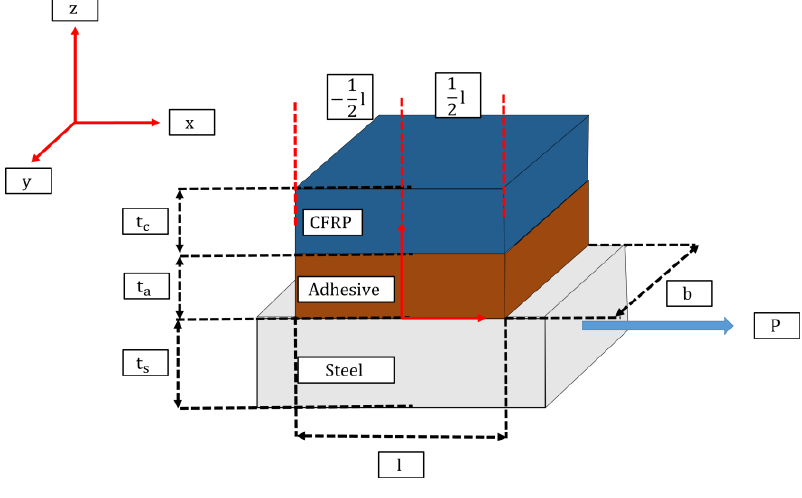
Figure 4. Diagram of single lap joint.